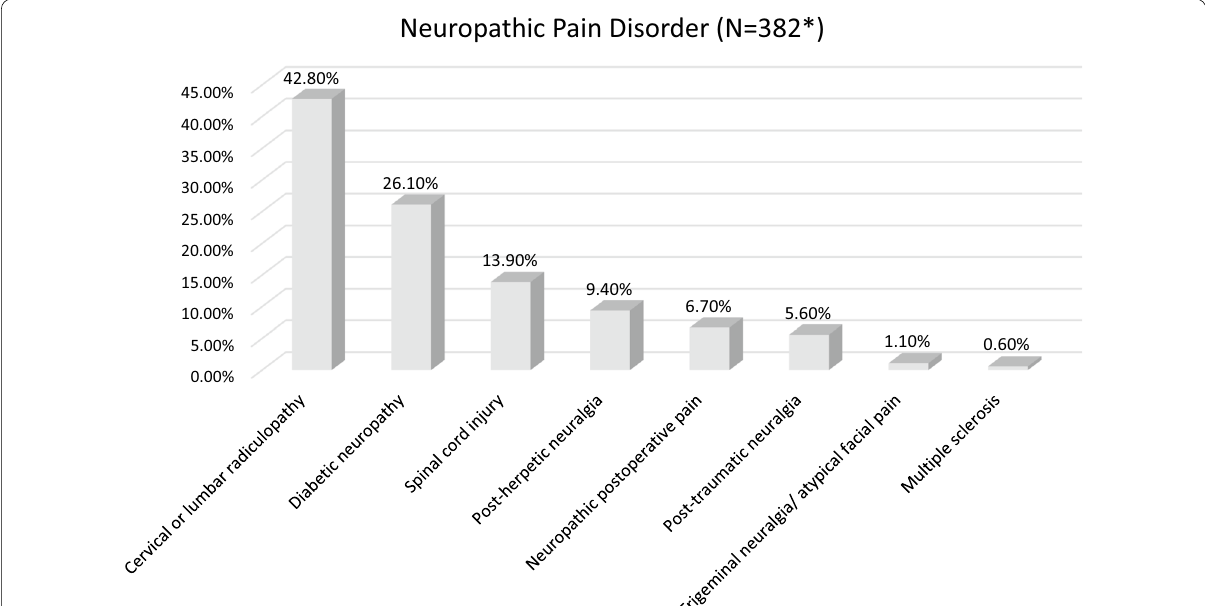
Figure 1 Prevalence of the different types of neuropathic pain. *22/360 patients were diagnosed with more than one type of neuropathic pain disorder